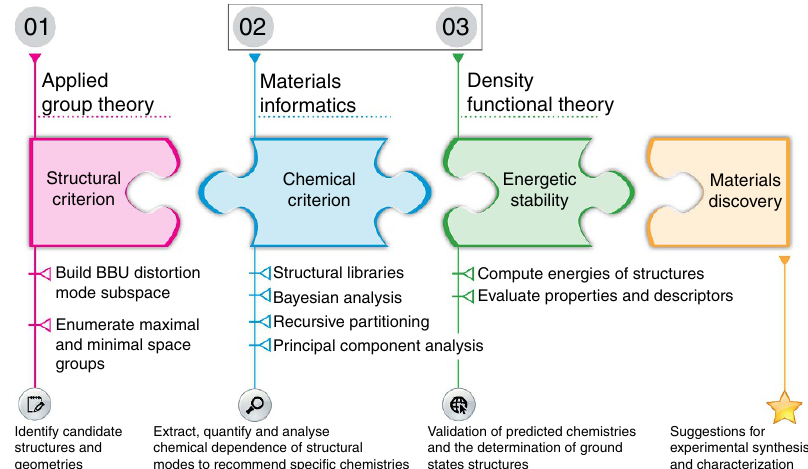
Figure 2 | Predictive materials discovery framework. Synergistic integration of applied group theory, materials informatics and ab initio electronic structure calculations for designing novel functional materials. Applied Group Theory determines the geometric rules, uncovers the crystallographic symmetry restrictions and then subsequently shows how to lift them to achieve NCS structures for a given crystal structure topology. Materials informatics uses the data from experiments, features (such as orbital radii) that capture the chemical trends in the constructed data set and statistical inference tools to extract QCSR that guides selection of chemical compositions. DFTcalculations validate the predictions from materials informatics. We then recommend the validated chemical compositions for experimental synthesis and characterization, eventually leading to its discovery. Experimentally synthesized compositions augment the training set for a second materials informatics iteration and the process repeats until desired materials are discovered 14 . In this paper, we focus on computational tasks 2 and 3 (boxed).